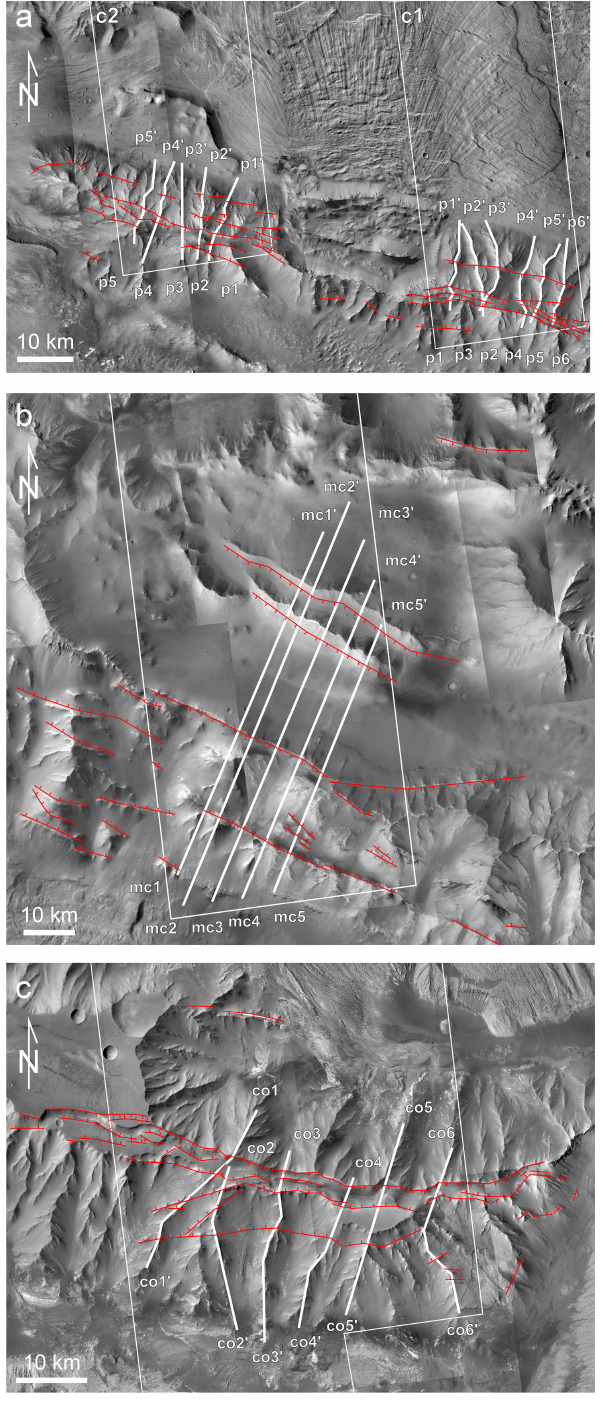
Figure 6. Martian sites, location of the analysed fault scarps (red), CTX DEM (white boxes) and profiles (numbered white lines) used for fault displacement analysis. (a) Site M1; (b) Site M2; (c) Site M3. MRO–CTX mosaics realised with JMARS (Christensen et al., 2009).